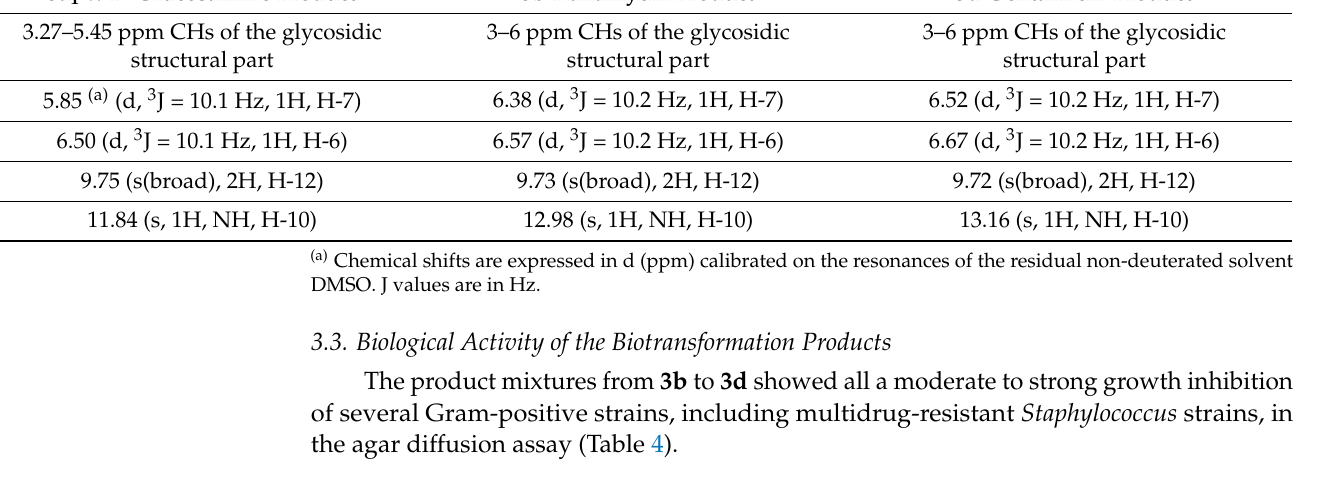
Table 4. Antimicrobial activity of products 3a – 3d , and educts 2a and 1a – 1d